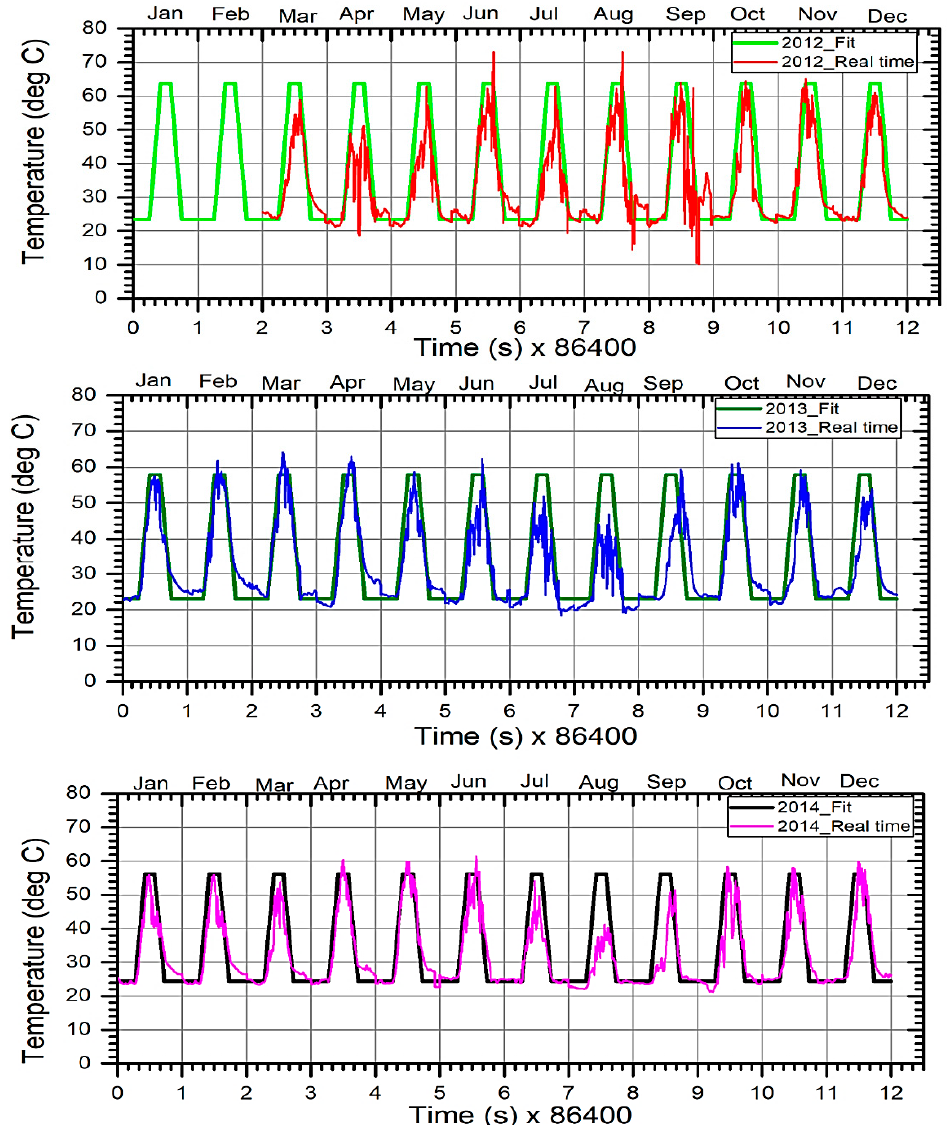
Figure 3. In-situ thermal cycle profiles fitted onto real-time module temperature profile for 2012–2014 [20]. Figure 3. In ‐ situ thermal cycle profiles fitted onto real ‐ time module temperature profile for 2012– 2014 [20].